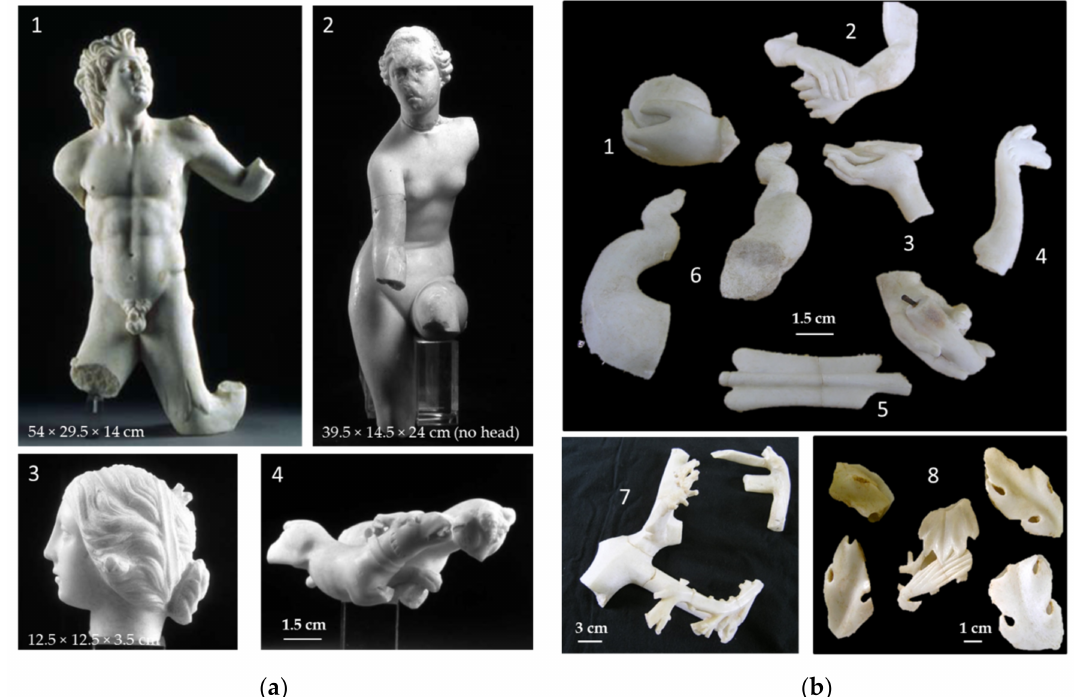
Figure 2. Some of the recovered sculptures: ( a ) (1) Anguiped male creature, (2) Venus holding a sandal, (3) ideal female head (nymph), (4) two hunting group animals; photographs by J. Pessoa, Instituto Portugues de Museos (IPM); ( b ) various fragments such as (1) Uranus muse hand, (2) female arm leaning on male arm, (3) two female hands holding objects, (4) gryphon head ship bow, (5) rudder tip, (6) two angled tail ends, (7) fragments of tree trunks and (8) leaves; photographs by M.P., Lapuente